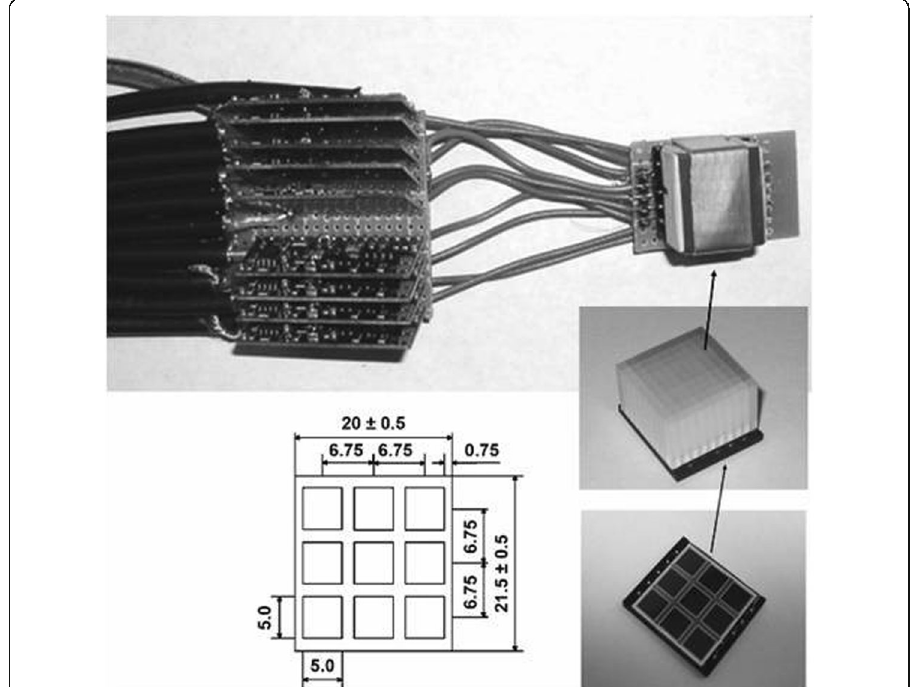
Fig. 4 LSO-APD detector assembly: 10×10 LSO array (centre right) was coupled by custom-made light guide to 3×3 APD array (bottom right) (This research was originally published in B. J. Pichler et al. , “ Performance test of an LSO-APD detector in a 7-T MRI scanner for simultaneous PET/MRI, (Pichler et al. 2006) ” J. Nucl. Med., vol. 47, no. 4, pp. 639 – 647, 2006. © by the Society of Nuclear Medicine and Molecular Imaging,